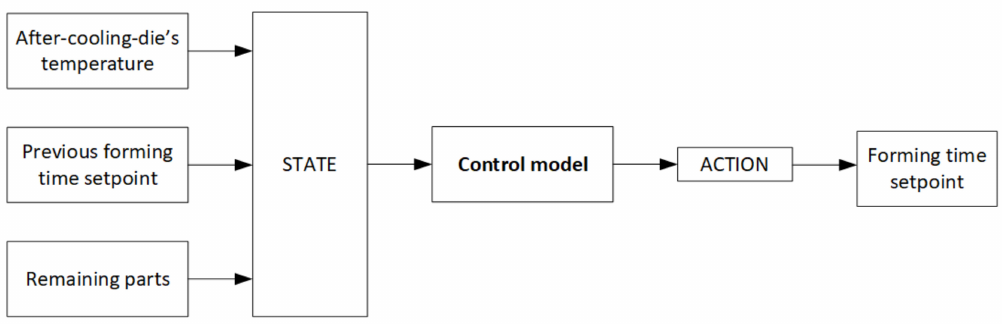
Figure 4. Workflow of the control